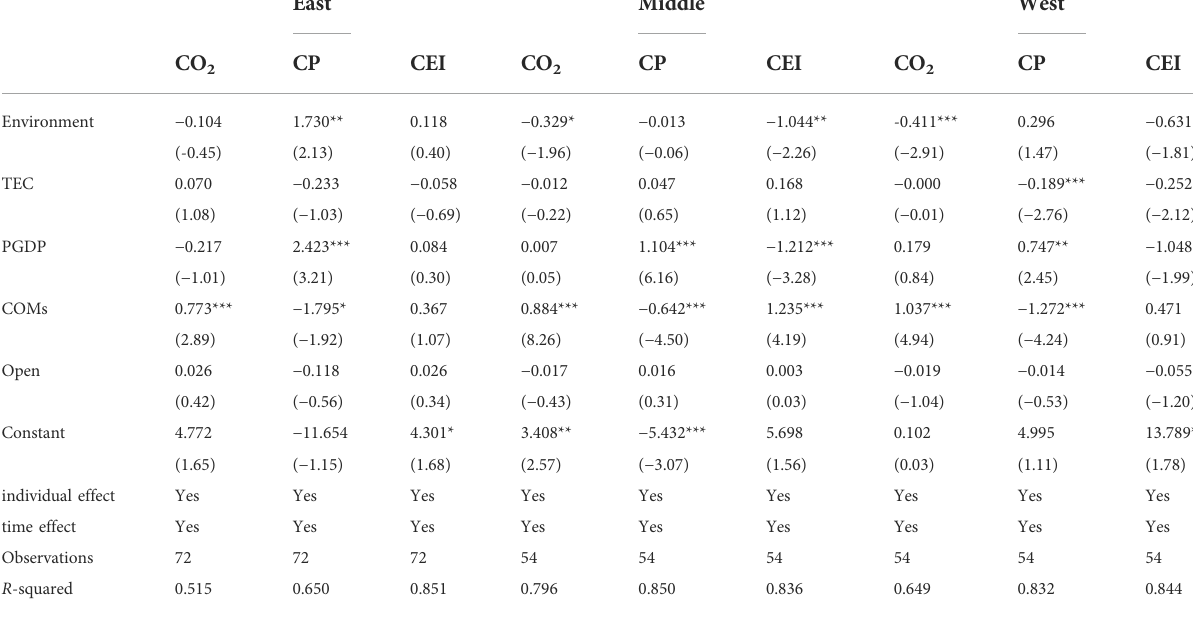
TABLE 8 The effect of regional environmental investments on carbon emission in the East, Middle, and West